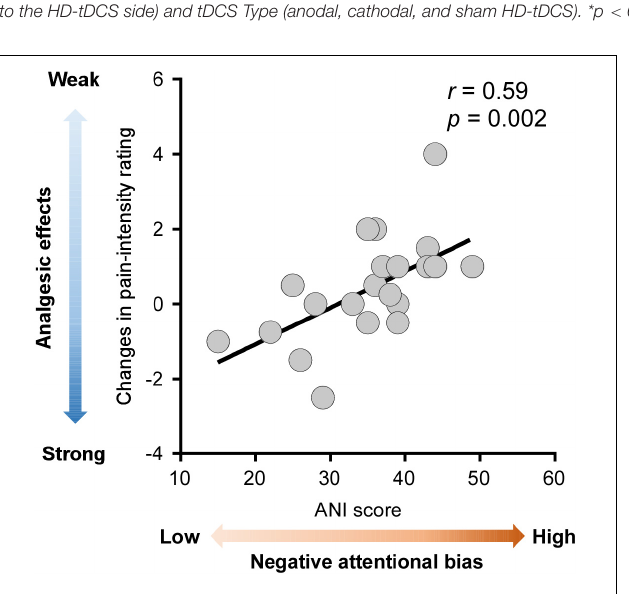
and unpleasantness ratings. Analgesic effects of anodal